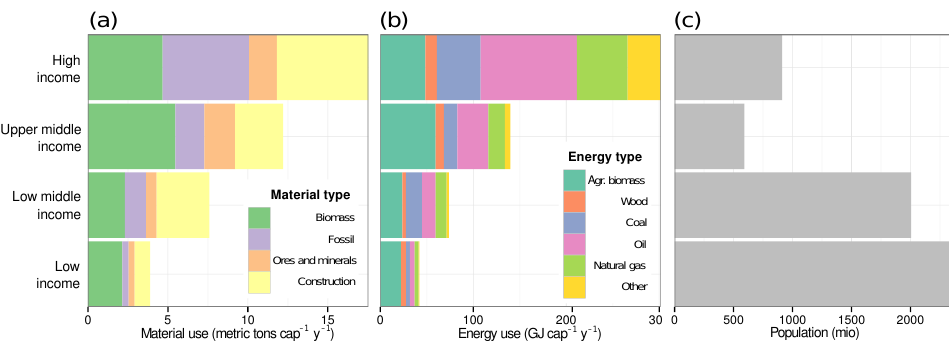
Figure 2. Year 2000 (a) material (Steinberger et al., 2010) and (b) energy use per capita (Krausmann et al., 2008a) and (c) total population (data.wordbank.org), by income